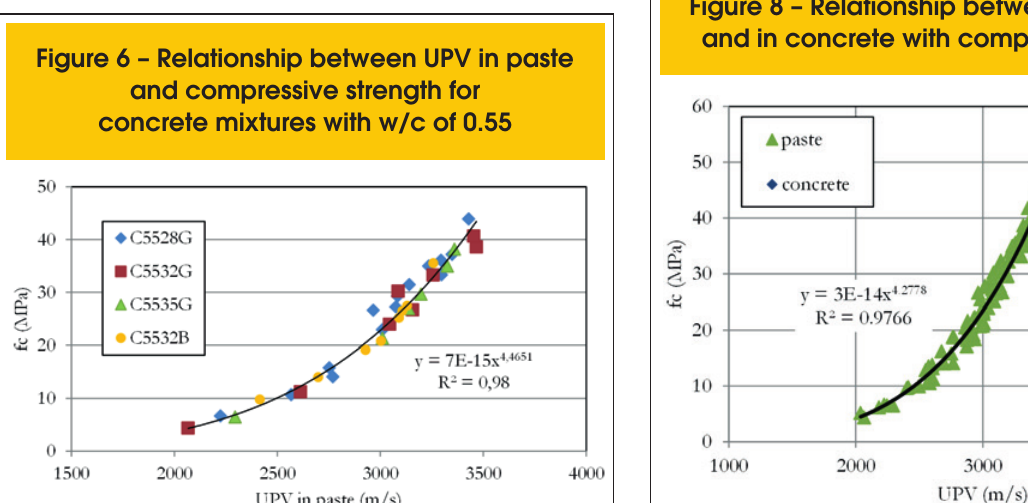
Figure 8 – Relationship between UPV in paste and in concrete with compressive